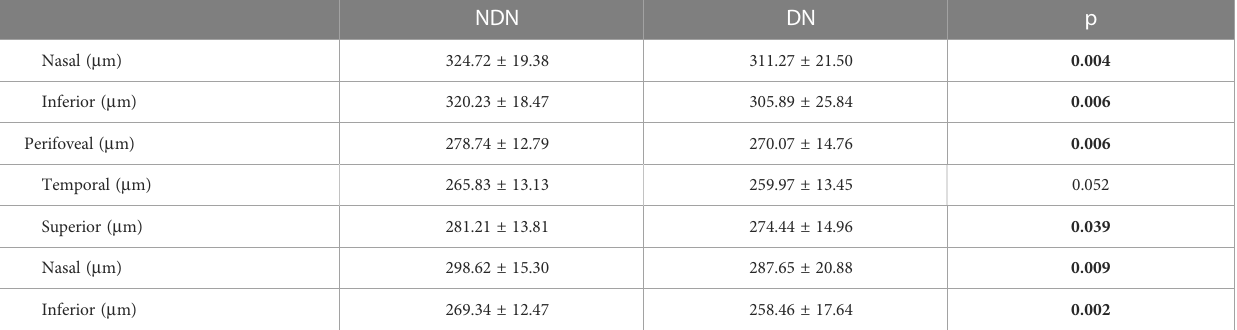
TABLE 4 Peripapillary capillary density and retinal nerve fi bre layer (RNFL)